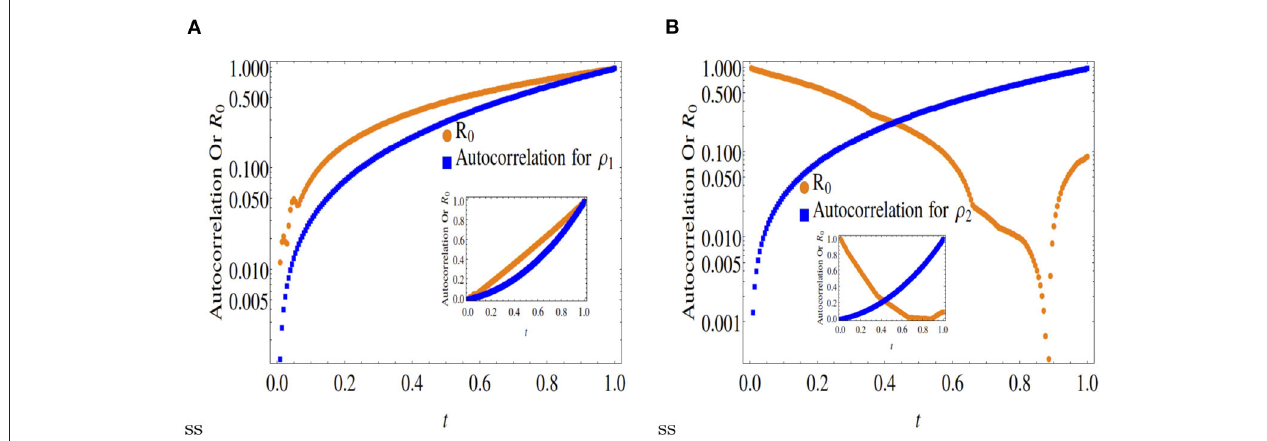
FIGURE 5 | Comparison of normalized autocorrelation and R 0 at x = 0.7. Outset is in log scale and inset is in original scale. (A) Autocorrelation and R 0 of ρ 1 at x = 0.7. (B) Autocorrelation and R 0 of ρ 2 at x =